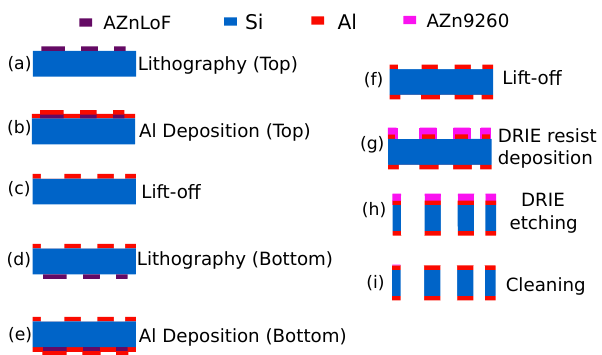
Figure 6. ( a – i ) Fabrication steps for the passive